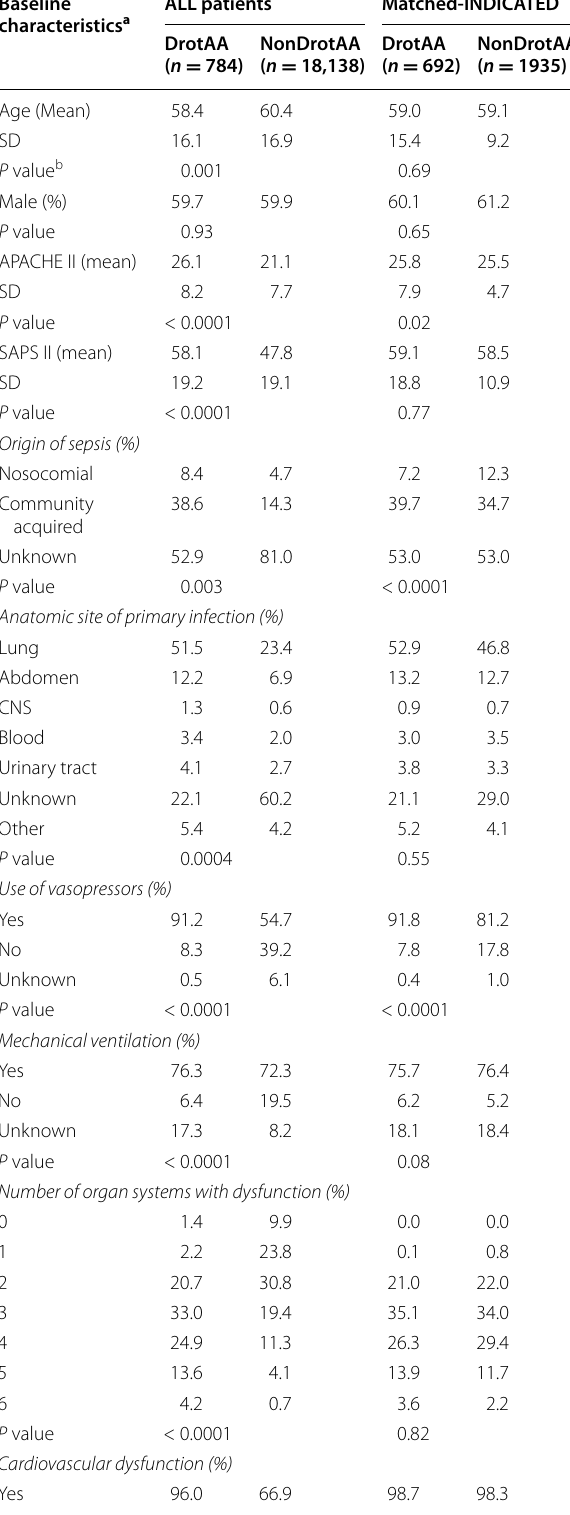
Table 1 Baseline characteristics for ALL and matched- INDICATED populations by treatment Baseline characteristics